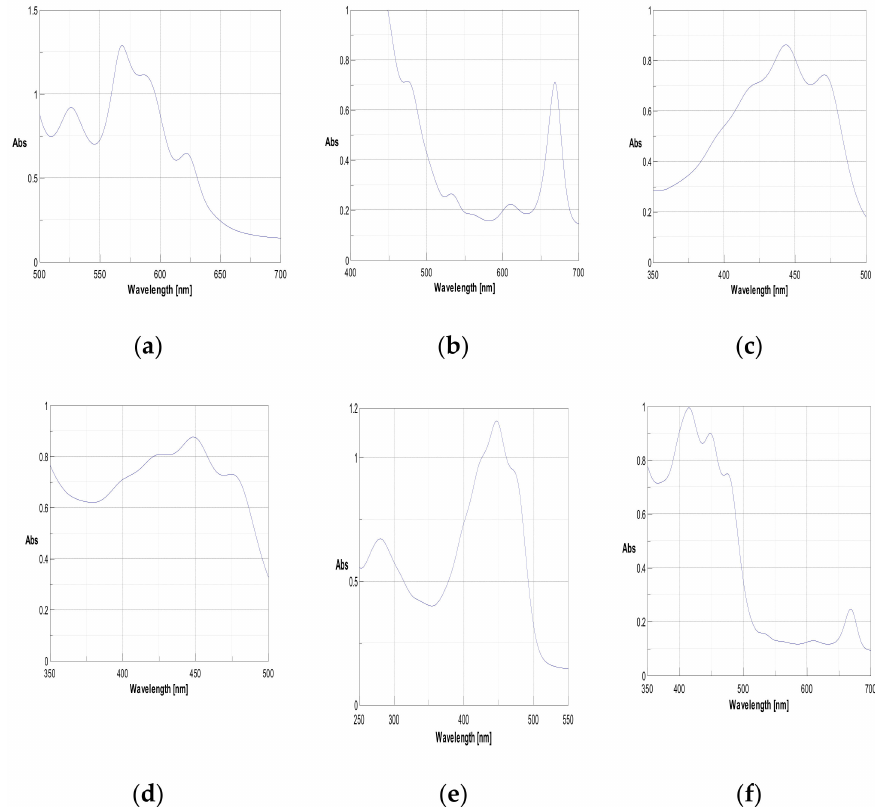
Figure 1. Typical spectral fingerprints of six authentic oils absorbing in the Vis region (360–700 nm): ( a )—Pumpkin oil; ( b )—Hempseed oil; ( c )—Linseed oil; ( d )—Soybean oil; ( e )—Sea buckthorn oil; ( f )—Olive